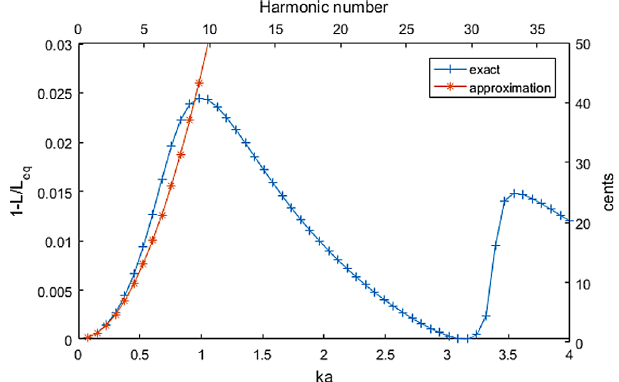
¼ (cid:2) I as a function of ka for L = 1 m, Figure 3. 1 (cid:2) L L eq l = 180 g/m , a = 2.4 cm and m = 5 g (Eqs. (6) and (8) for the approximation) . Harmonics for which 1 (cid:2) L marked with crosses and stars and harmonic number is indicated with an upper scale. Right scale in cents is for 1200 log